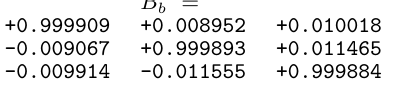
Table 2. Recovered bore-sight matrix (radians).